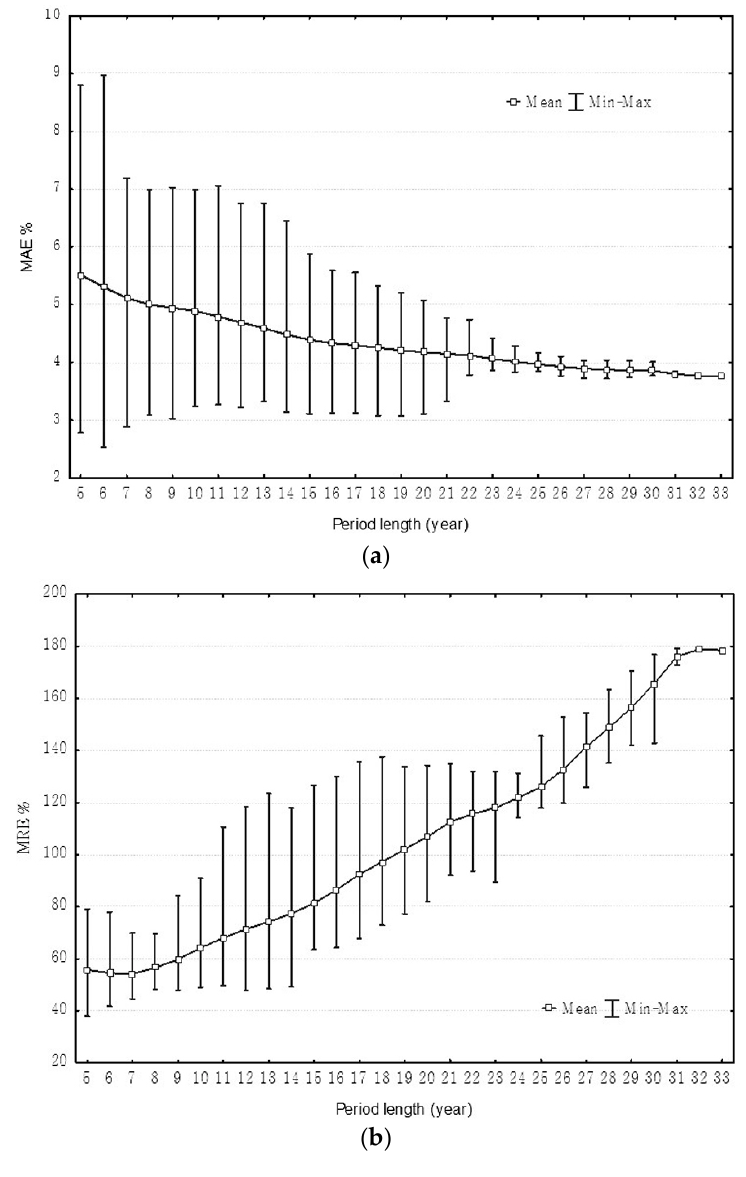
Figure 4. ( a ) MAE and ( b ) MRE of daily fire probability predicted for periods of different time spans.